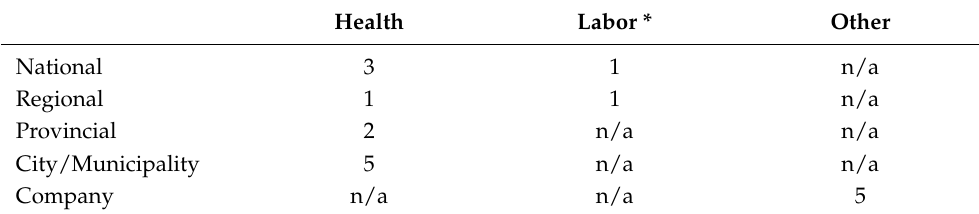
Table 1. Key informants by sector and level, February–March 2022.